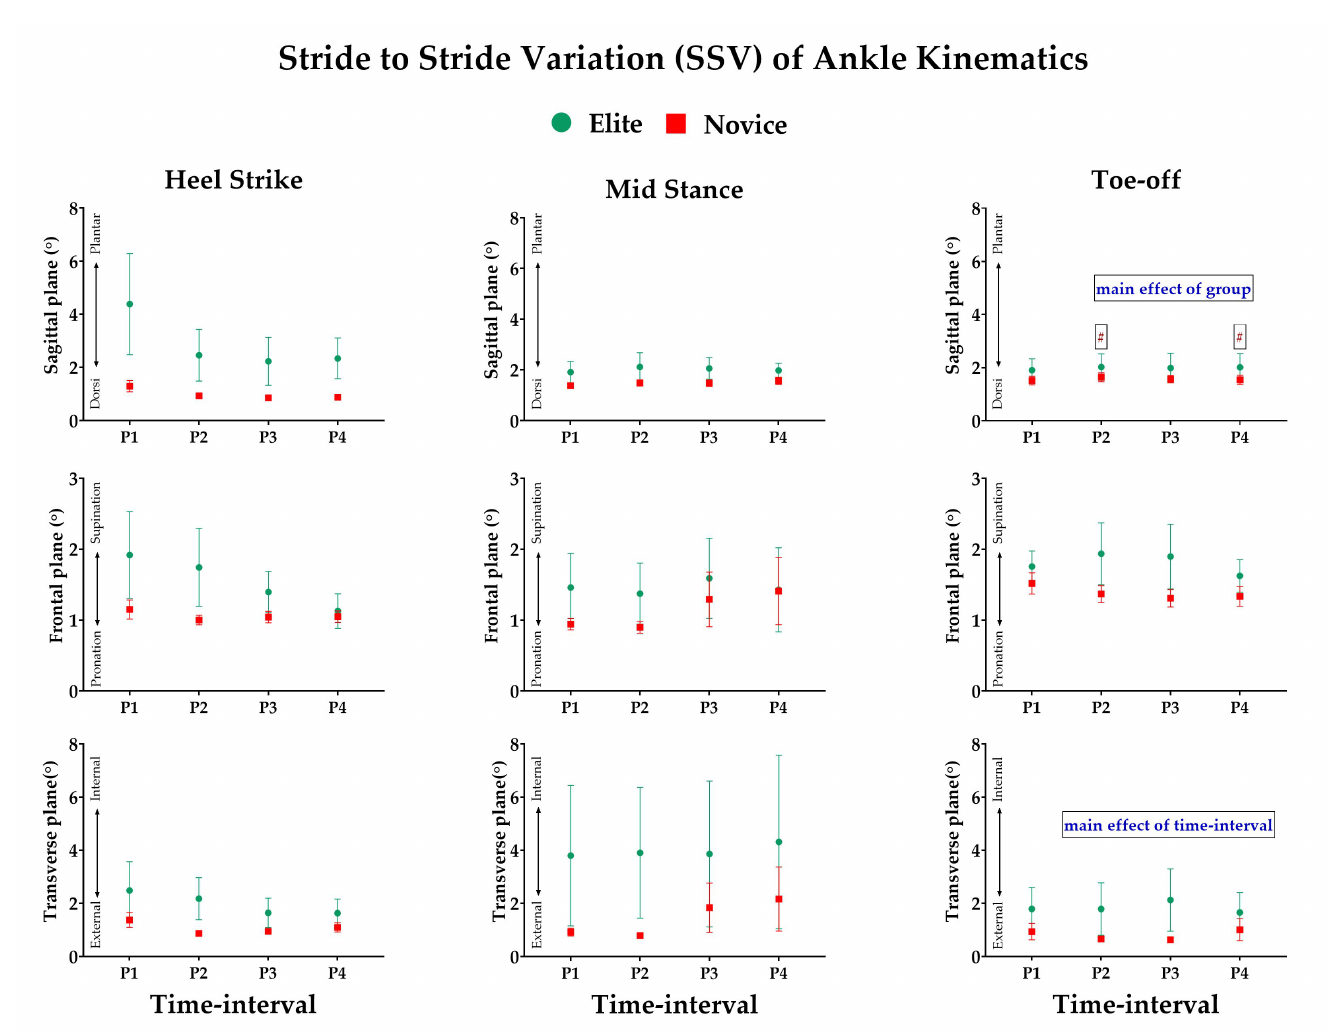
Figure A5. The results of the kinematics of ankle joint SSV angle between elites (circle) and novices (square) in each phase of the prolonged run. The computed variable of SSV is represented on the Y -axis. The time-interval calculated by increasing the window size every five minutes is represented on the X -axis (P1: 0 to 5 min; P2: 0 to 10 min; P3: 0 to 15 min; and P4: 0 to 20 min). The figure depicts a significant main effect of group, time interval, and interaction. Significant differences in a group for a specific time interval are marked with a “#”. (Note: only results with significant interaction have been